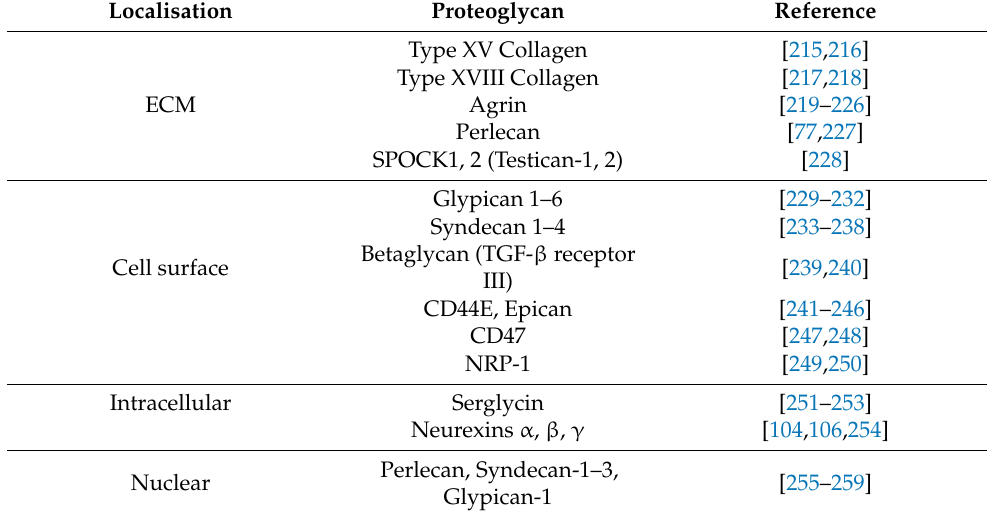
Table 1. Extracellular, Cell membrane, Intracellular and Nuclear